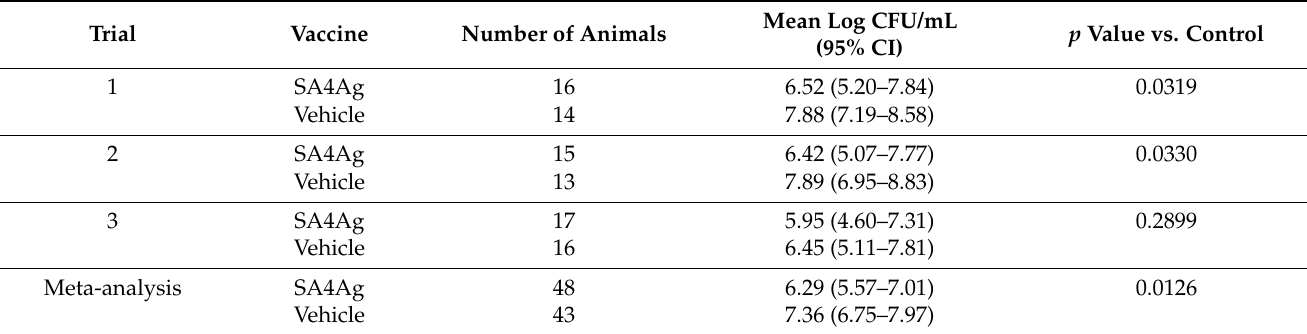
Table 4. Immunization with SA4Ag Reduces Recovered CFU of a CP5-expressing S. aureus Clinical Isolate in a Rat Endocarditis